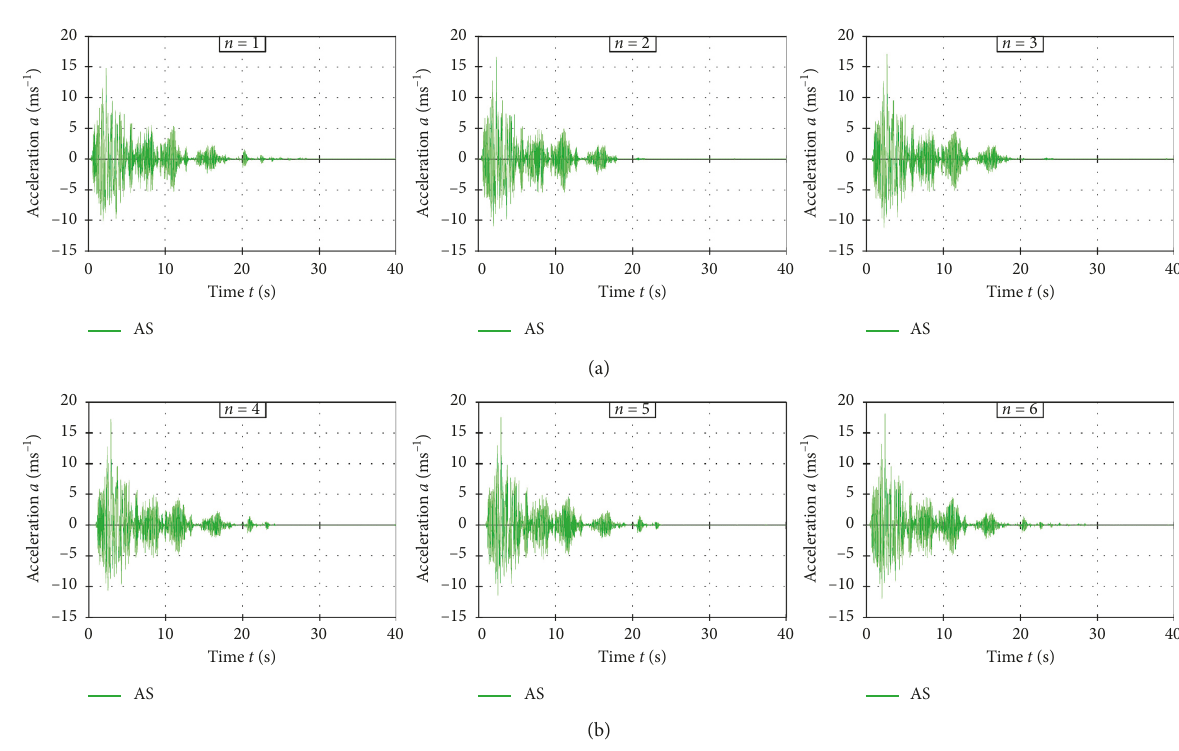
Figure 30: Horizontal acceleration a for repeated excitation